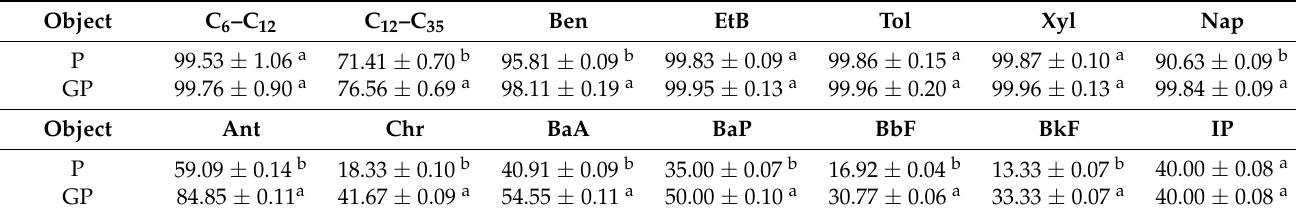
Table 1. Effect of cocksfoot on degradation of petrol hydrocarbons in the soil, in %.